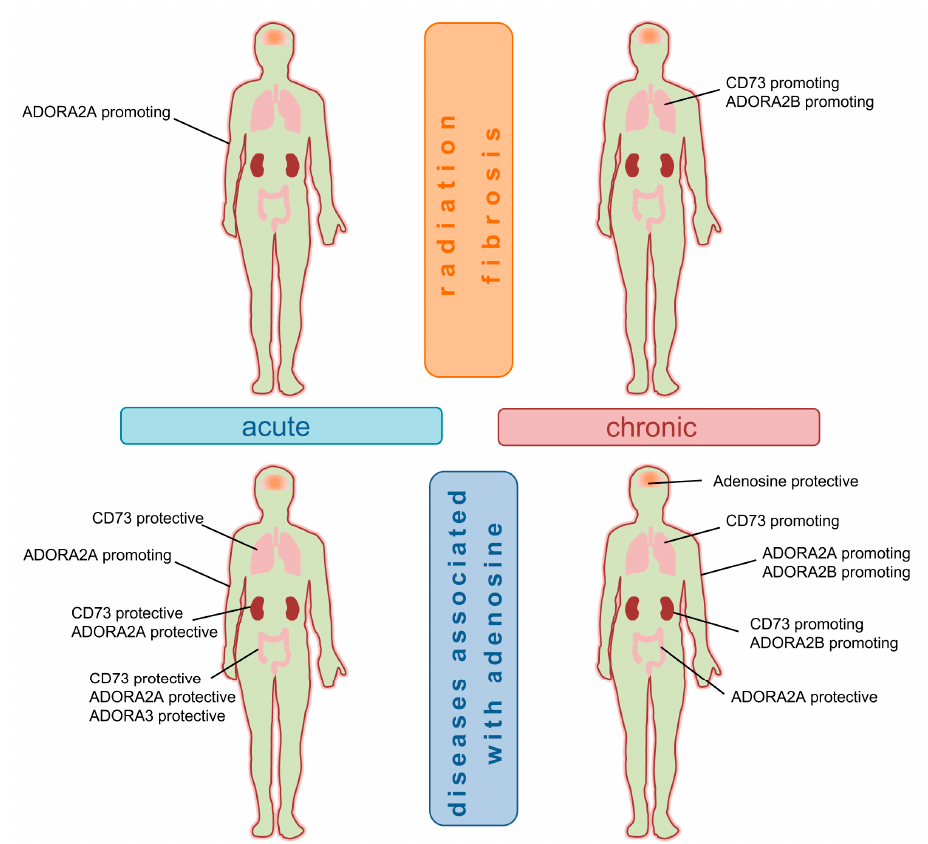
Figure 2. Role of Purinergic Signaling in acute and chronic disease states. Schematic overview about the different roles of components of the purinergic signaling system in acute versus chronic as well as radiation-induced versus adenosine-induced. The role of the different components is highly tissue- and model-dependent so that no general conclusions can be drawn, although there is a tendency for CD73 being a protector in acute injury models and a disease promotor in chronic injury models as well as for ADORA2B having pathologic functions in chronic disease models. (The human silhouette is only representative for a corpus. Results are obtained from clinical and preclinical data).